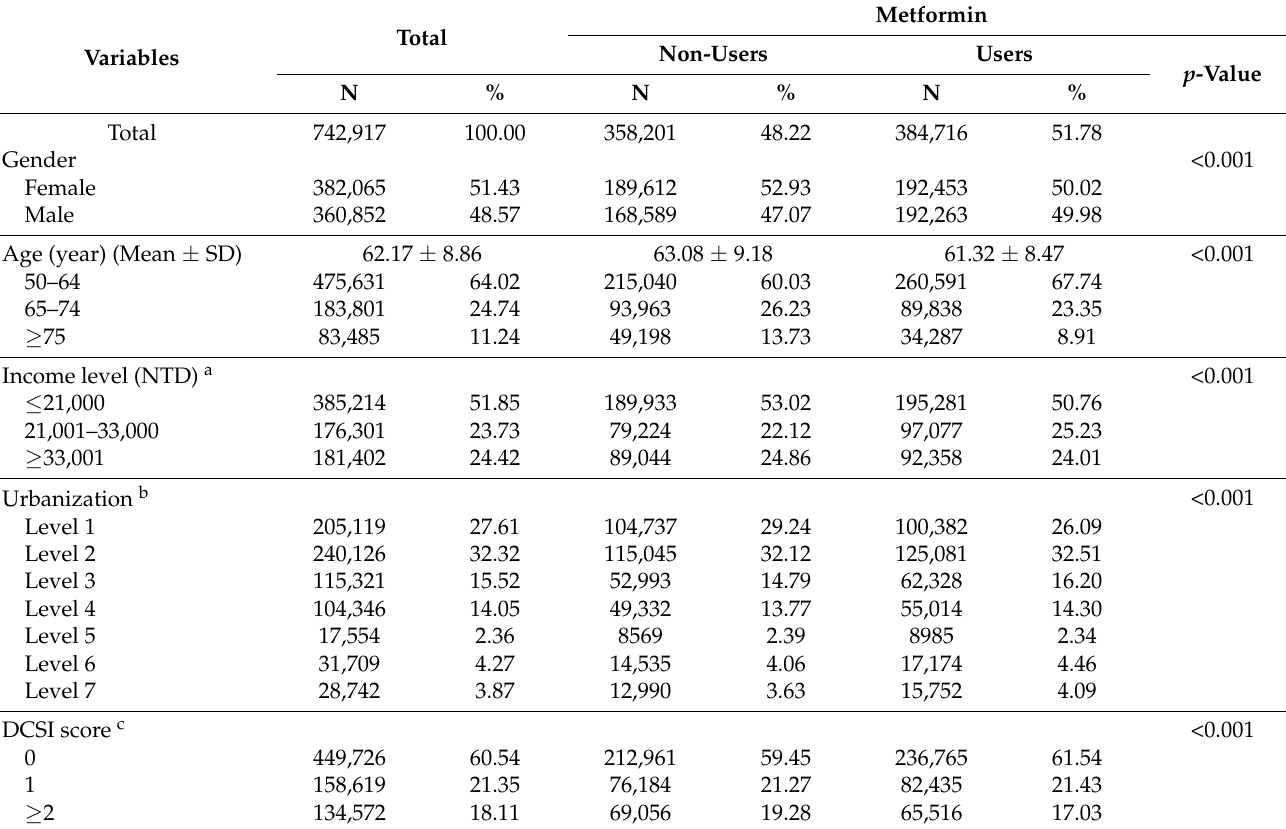
Table 1. Baseline characteristics of patients with new-onset diabetes